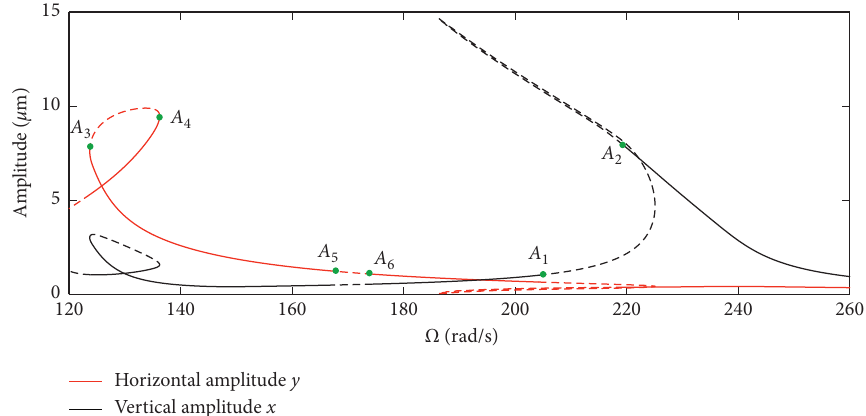
Figure 3: Stable (solid) and unstable (dashed) period-1 frequency-response peak-to-peak curves in (a) the x -direction and (b) the y direction for δ 0 � 6.0 μ m and (c) �